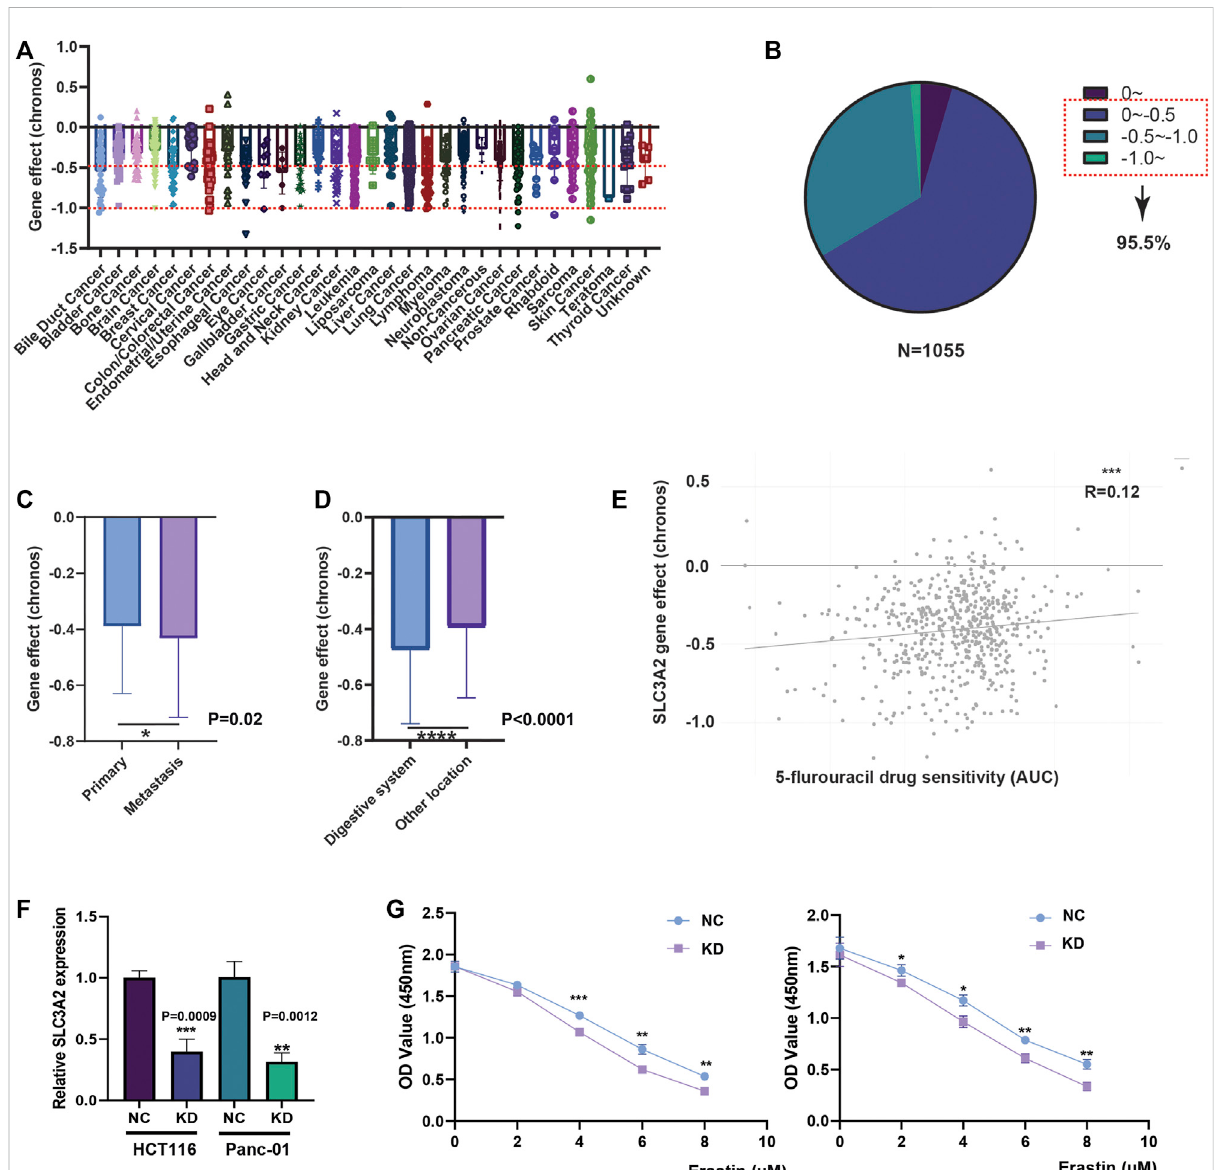
FIGURE 3 Effect of SLC3A2 on cell-proliferation and drug sensitivity in tumor cell-lines. (A) Gene effect of SLC3A2 in all cell-lines. (B) Strati fi cation and proportion of cell-lines with different gene effect. (C) Metastatic cell-lines depends more on SLC3A2 expression to sustain rapid proliferation. (D) Digestive cell-lines depends more on SLC3A2 expression to sustain rapid proliferation. (E) SLC3A2 gene effect was mildly correlated with 5-FU sensitivity. (F) RNAi ef fi ciency of SLC3A2 knockdown. (G) SLC3A2 knockdown improved sensitivity to ferroptosis in both HCT116 and Panc-01